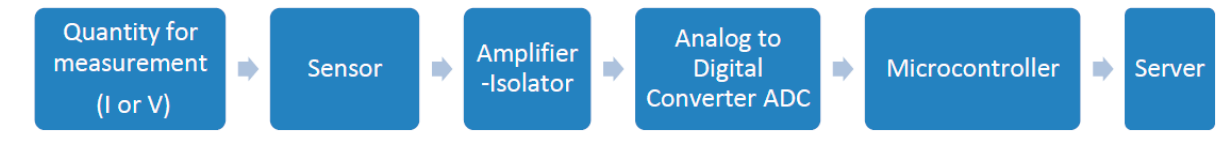
Figure 9. Block diagram of measuring system.